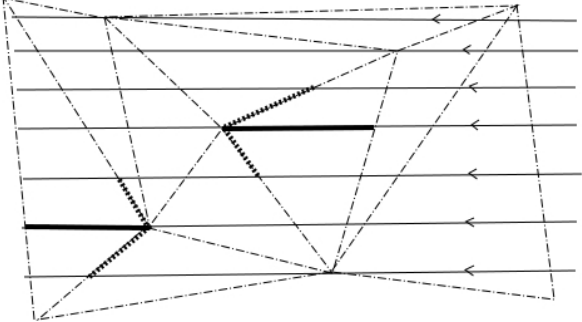
Figure 4. Outer and inner transversals associated to the extreme singular points of the bold 1-simplices. The leafwise triangulation is induced by a transverse